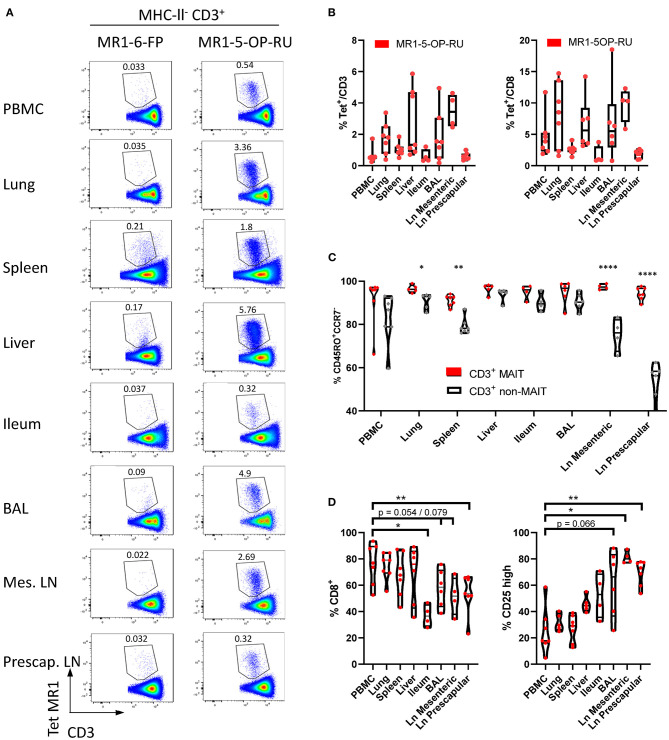
Comparisons of the frequencies and phenotype of cattle MAIT cells in different tissues. (A) Representative flow cytometry plots of MR1-5-OP-RU tetramer gating within MHC-II− CD3+ cells in different tissues. (B) Frequencies of CD3+ MR1-5-OP-RU tetramer+ MAIT cells and CD8+ MR1-5-OP-RU tetramer+ MAIT cells in different tissues from cattle. Number of animals per tissue are given in Supplementary Table 2. (C) Frequency of effector memory (CD45RO+CCR7−) MAIT (CD3+ tetramer+) and non-MAIT T cells (CD3+ tetramer−). Mixed effects model with matching across tissue and cell population, followed by Sidak's multiple comparisons post-hoc test comparing differences between MAIT and non-MAIT cells within tissues. (D) Frequency of CD8+ or CD25 high MAIT cells (CD3+ MR1-5-OP-RU+). Mixed effects model with matching across tissue, followed by Dunnet's multiple comparisons post-hoc test comparing differences between PBMC and other tissues.